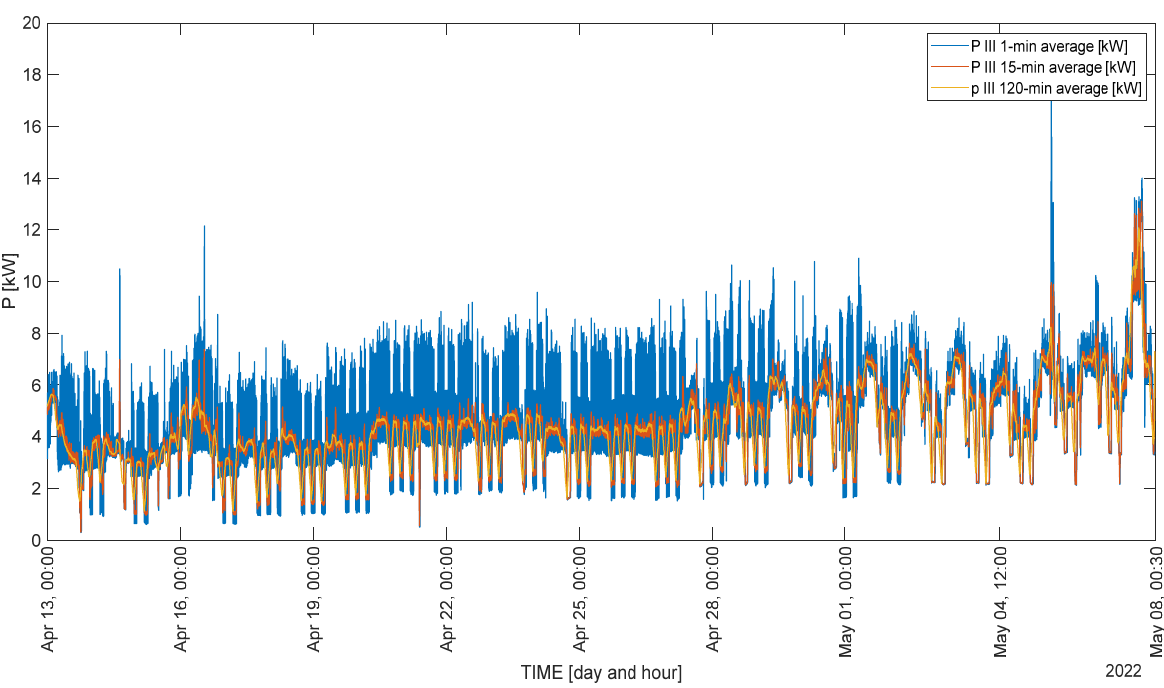
Figure 4. Three-phase reactive power as a function of time in the 1st stage of the cycle.